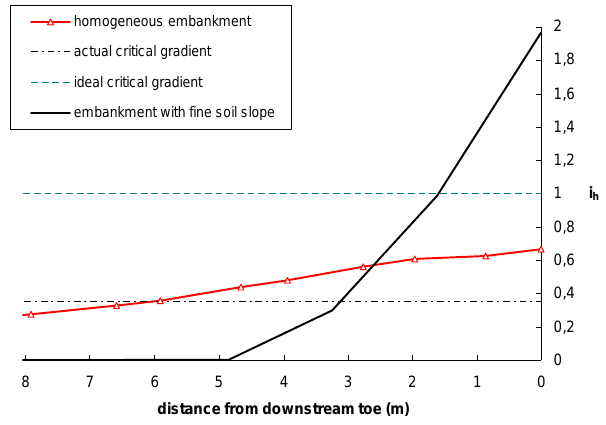
Figure 13 – Outflow horizontal gradient calculated at the downstream toe (see blue line in 4 Fig. 13. Outflow horizontal gradient calculated at the downstream Figure 8) at time t = 6 h (see Figure 9) for different embankment configurations and 5 toe (see blue line in Fig. 8) at time t = 6h (see Fig. 9) for different comparison with gradient values critical for the onset of piping.6 embankment configurations and comparison with gradient values critical for the onset of